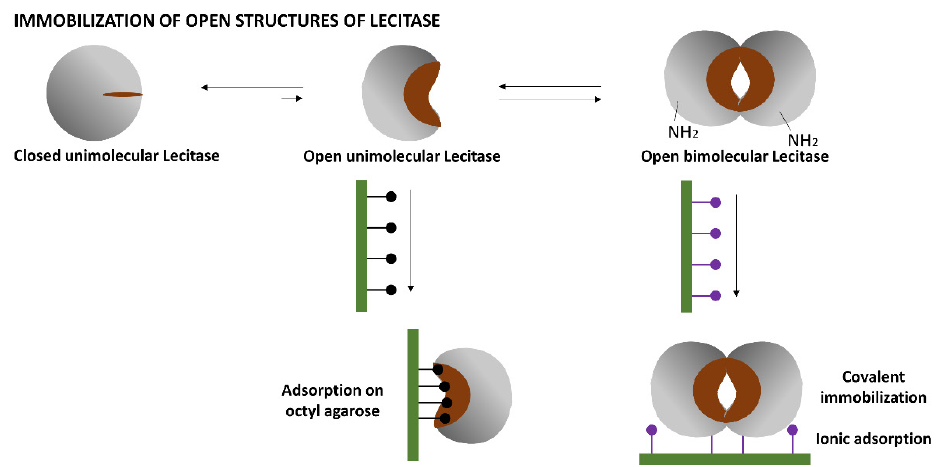
Figure 1. Possible structures of Lecitase in solution. Mechanisms for immobilization of the open structure of Lecitase.